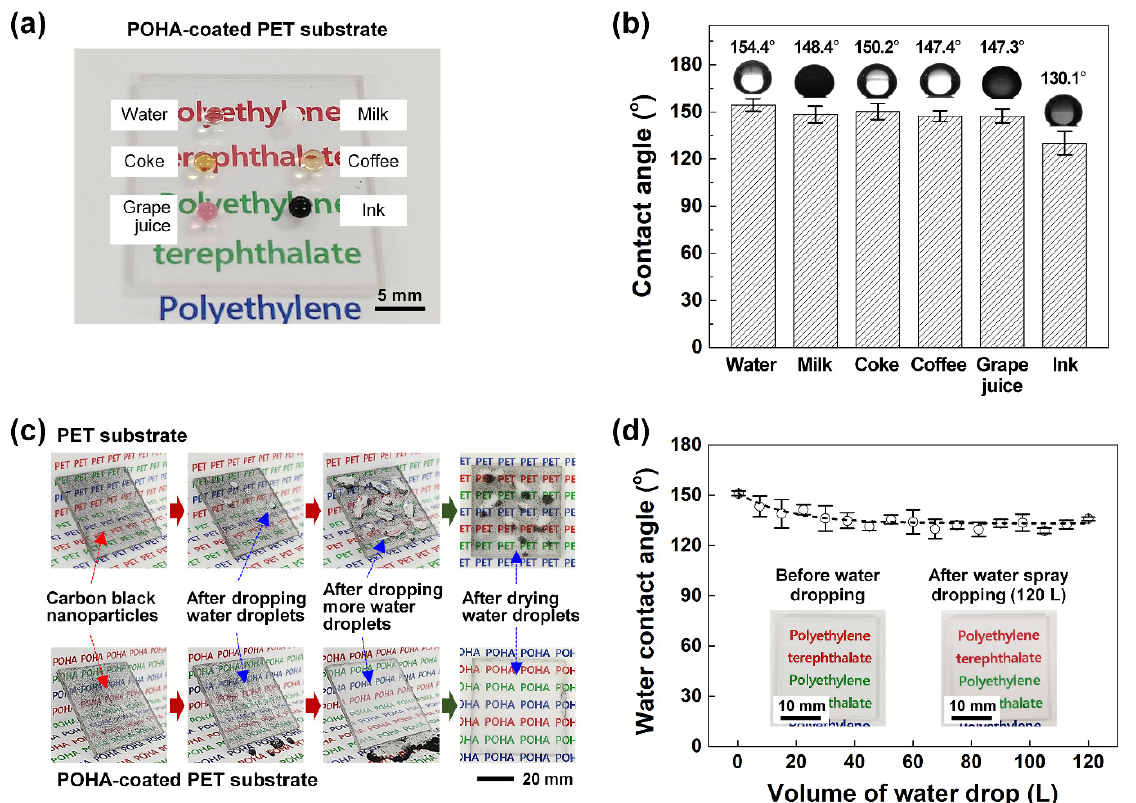
Figure 4. ( a ) Photographs showing that water, milk, Coke, coffee, grape juice, and ink solutions form droplets without spreading on the POHA-coated PET substrate. ( b ) WCAs of the water, milk, Coke, coffee, grape juice, and ink solutions on the POHA-coated PET substrate. ( c ) General PET substrate showing carbon black nanoparticle marks left by water and the POHA-coated PET substrate showing carbon black nanoparticle cleaned by water. ( d ) Change trend of WCAs of the POHA-coated PET substrate according to continuous water drops. The inset shows photo images of the POHA-coated PET substrate before and after the water dropping test.